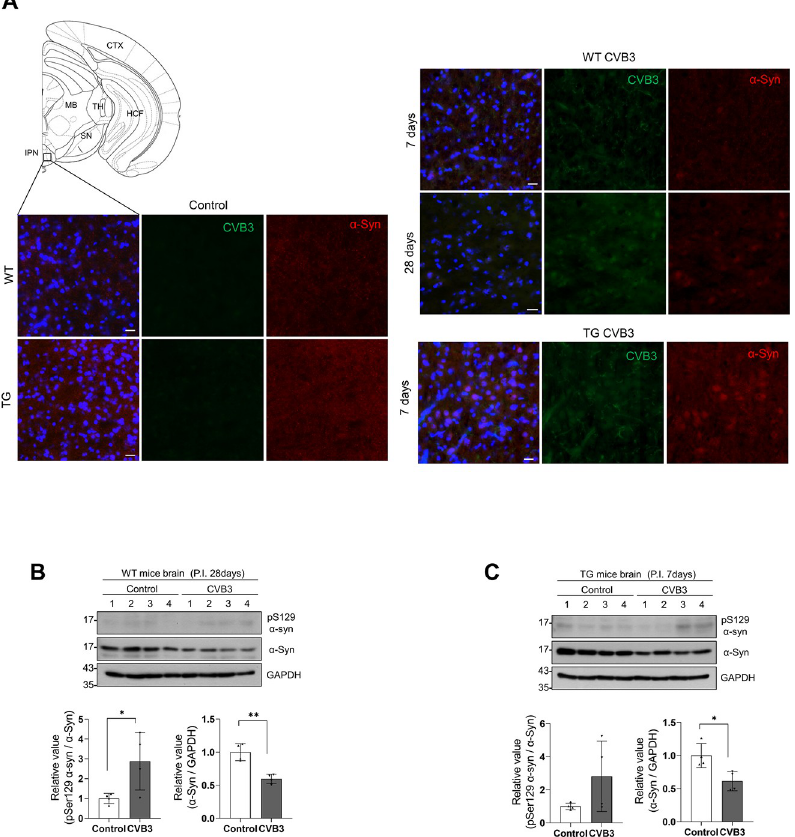
Fig 7. CVB3 induces α -syn inclusions in mice brains. (A) IHC images of control, CVB3 infected WT and α -syn TG mice brains at indicated days PI (IP injection of 1.0 × 10 6 PFUs of CVB3). Scale bar indicates 20 μ m. Blue indicates Hoechst. (Abbreviations of mouse brain regions: CTX-cortex, HCF-hippocampal formation, MB-midbrain, TH- thalamus, SN-substantia nigra, IPN-interpeduncular nucleus). (B and C) Western blotting was performed using control, CVB3 (IP injection of 1.0 × 10 6 PFUs of CVB3) infected WT and α -syn TG mice brain samples at indicated days PI. Protein levels were quantified by densitometry. ��� P < 0.001, �� P < 0.01, � P < 0.05, unpaired t-test. Fig 7A was modified after downloading the open source brain image (http://labs.gaidi.ca/mouse-brain-atlas).